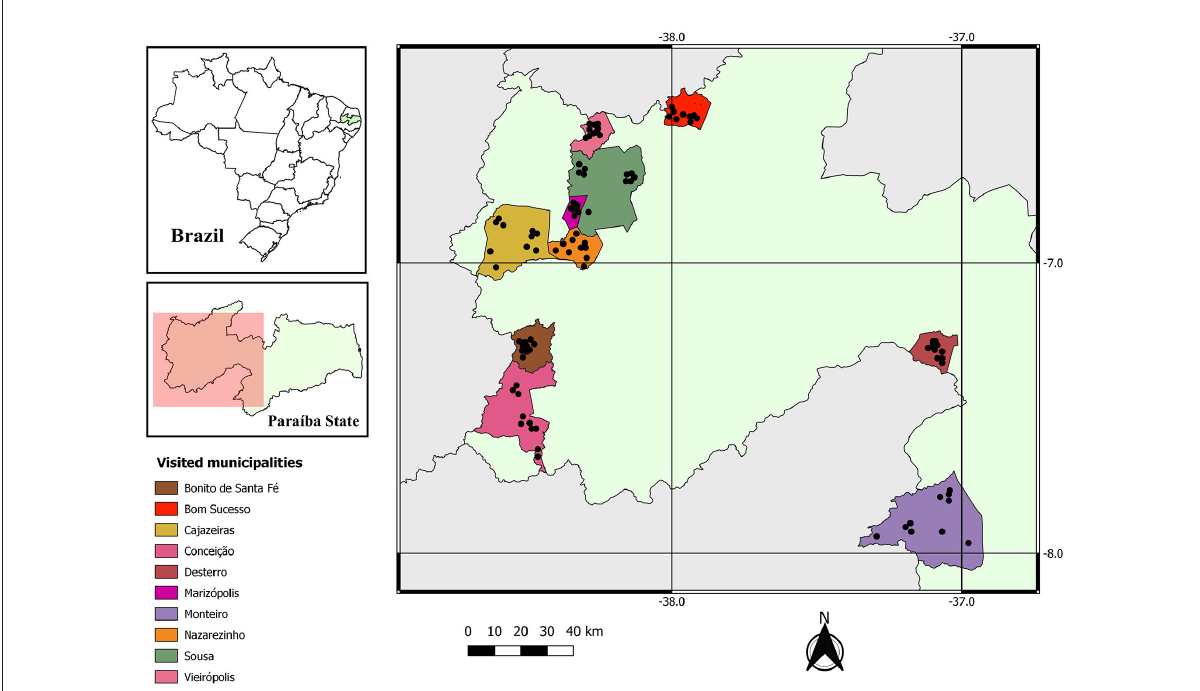
FIGURE1 Geographical locations of the municipalities visited for diagnosing infection by Eimeria spp. in free-range chickens in the semiarid region of Paraíba,